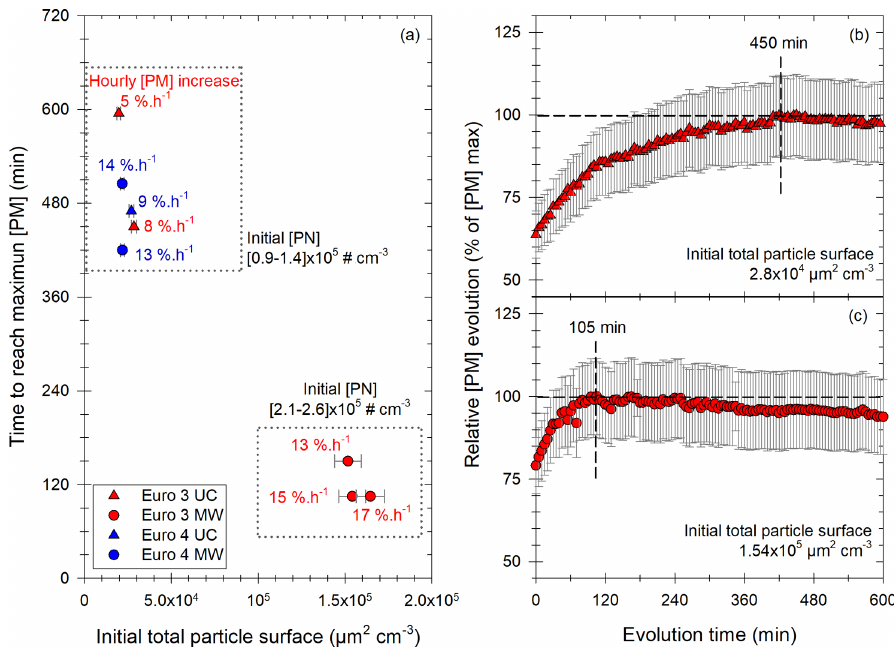
Figure 9. Results of the study of the [PM] evolution in the chamber for experiments showing a significant increase with the Euro 3 (red) and Euro 4 (blue) vehicles, under UC (triangles) or MW (circles) conditions. Panel (a) gives the time to reach the maximum of [PM] as a function of initial total particle surface. Each point has a label giving the hourly [PM] increase in percentage of initial [PM] per hour. Two groups are found: the first one (top) for initial [PN] between 0.9 and 1.4 × 10 5 cm − 3 , the second one (bottom) for initial [PN] between 2.1 and 2.6 × 10 5 cm − 3 . Panels (b) and (c) give two examples of those [PM] evolutions with time, plotted as the relative evolution of the maximum [PM]. Examples are taken: (b) from the first group of panel (a) with an initial surface of 2.8 × 10 − 4 µm 2 cm − 3 and a maximum [PM] reached in 450min and (b) from the second group of panel (a) with an initial surface of 1.54 × 10 5 µm 2 cm − 3 and a maximum [PM] reached in